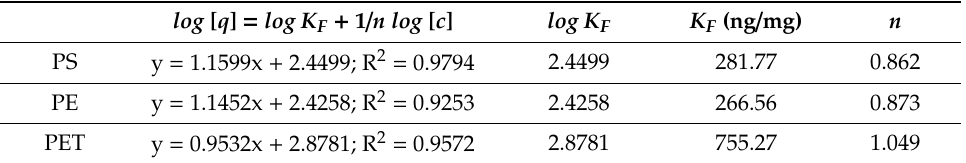
Table 3. Freundlich equation parameters for Σ PCBs on MPLs in the seawater / sediment